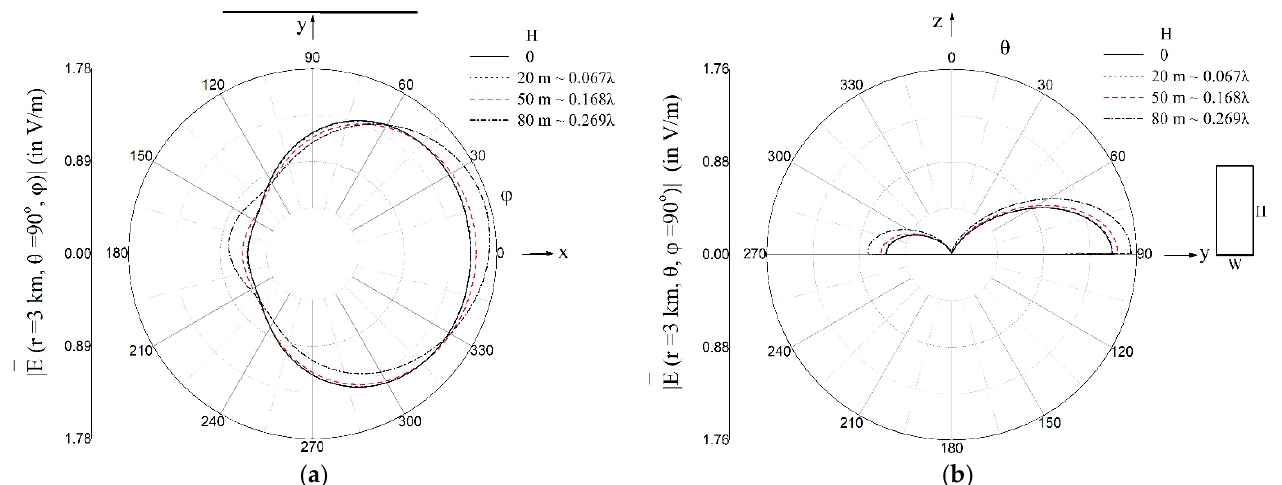
Figure 9. Radiation patterns of the array in free space (black, solid curve) and in the presence of a building with 𝐿 = 50 m ≈ 0.168𝜆 and 𝑊 = 10 m ≈ 0.034𝜆 . Three different heights H are considered (dashed and dotted curves, as indicated at the upper right corner). The distance between the antenna and the building is 𝑅 = 100 m ≈ 0.336𝜆 . ( a ) 𝜑 -plane and ( b ) 𝜃 -plane.